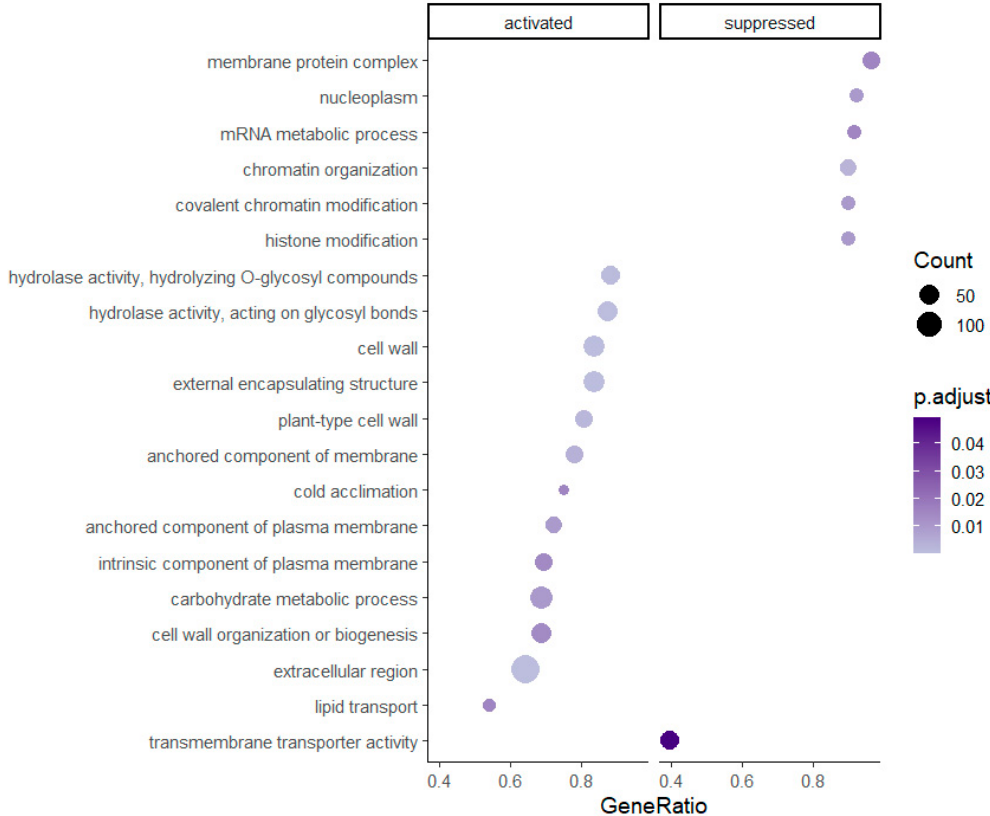
Figure 3. Significantly enriched gene set pathways resulting from the analysis of differentially expressed genes in tetraploid individuals of R. kuepferi .